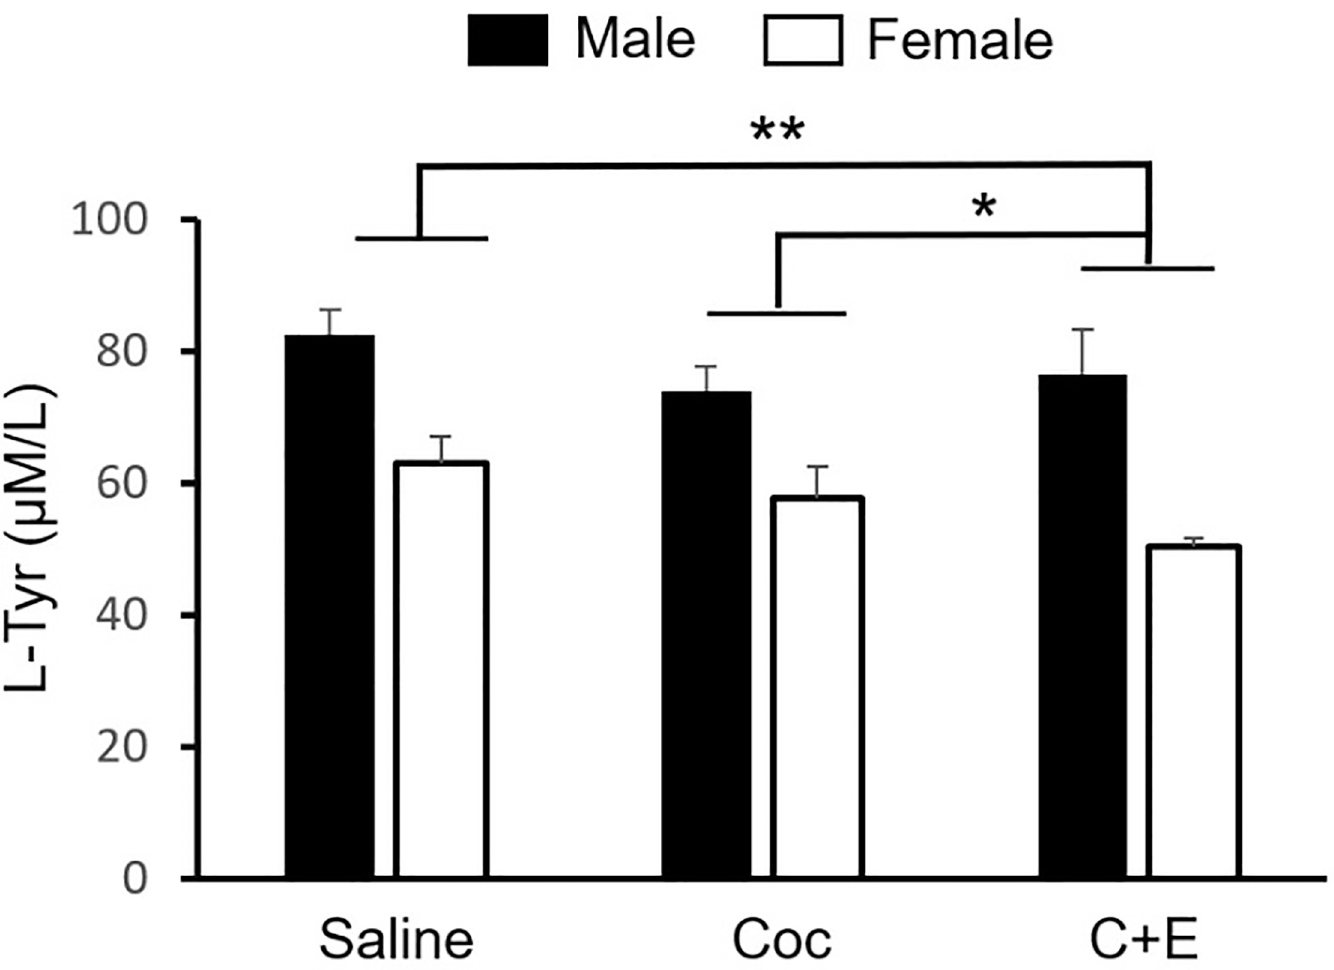
Fig 5. Plasma concentration of L-Tyr according treatment and sex. Mean ( ± SEM) of L-Tyr. Effects of Sex, reflected by the higher concentration in male rats, and Treatment were found (C+E vs. Coc; C+E vs. Sal). � P < 0.05; �� P <